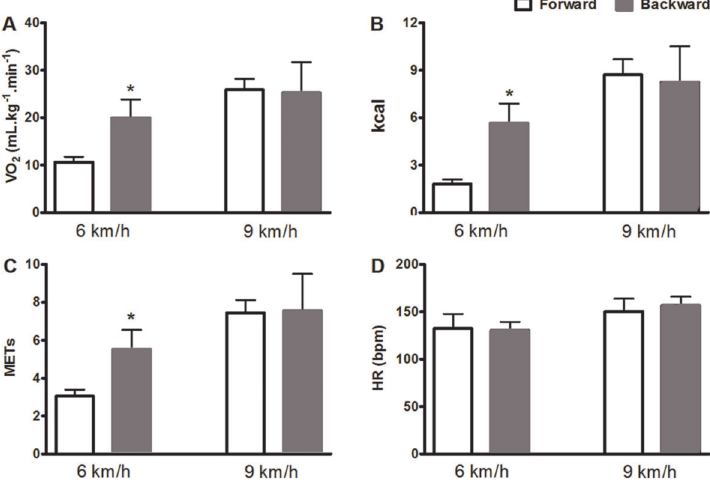
Figure 1. Energy expenditure in forward and backward movements at walking (6 km/h) and jogging (9 km/h) speeds. A , oxygen uptake (VO 2 ); B , kilocalories (kcal); C , metabolic equiva- lent (METs); D , heart rate (HR). *P=0.001 vs forward movements (Student ’ s paired t